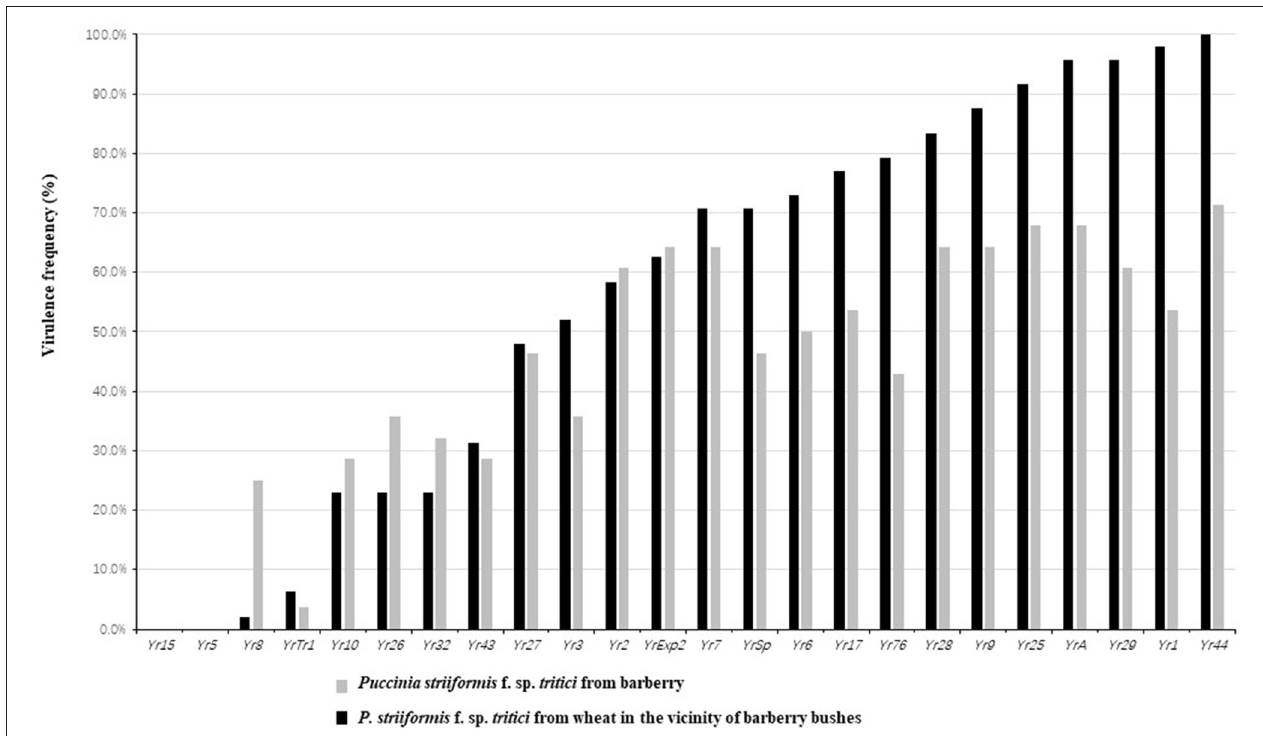
FIGURE 3 | Virulence frequency of Puccinia striiformis f. sp. tritici isolates obtained from barberry bushes and wheat plants adjacent to barberry on the 24 Yr single gene lines.